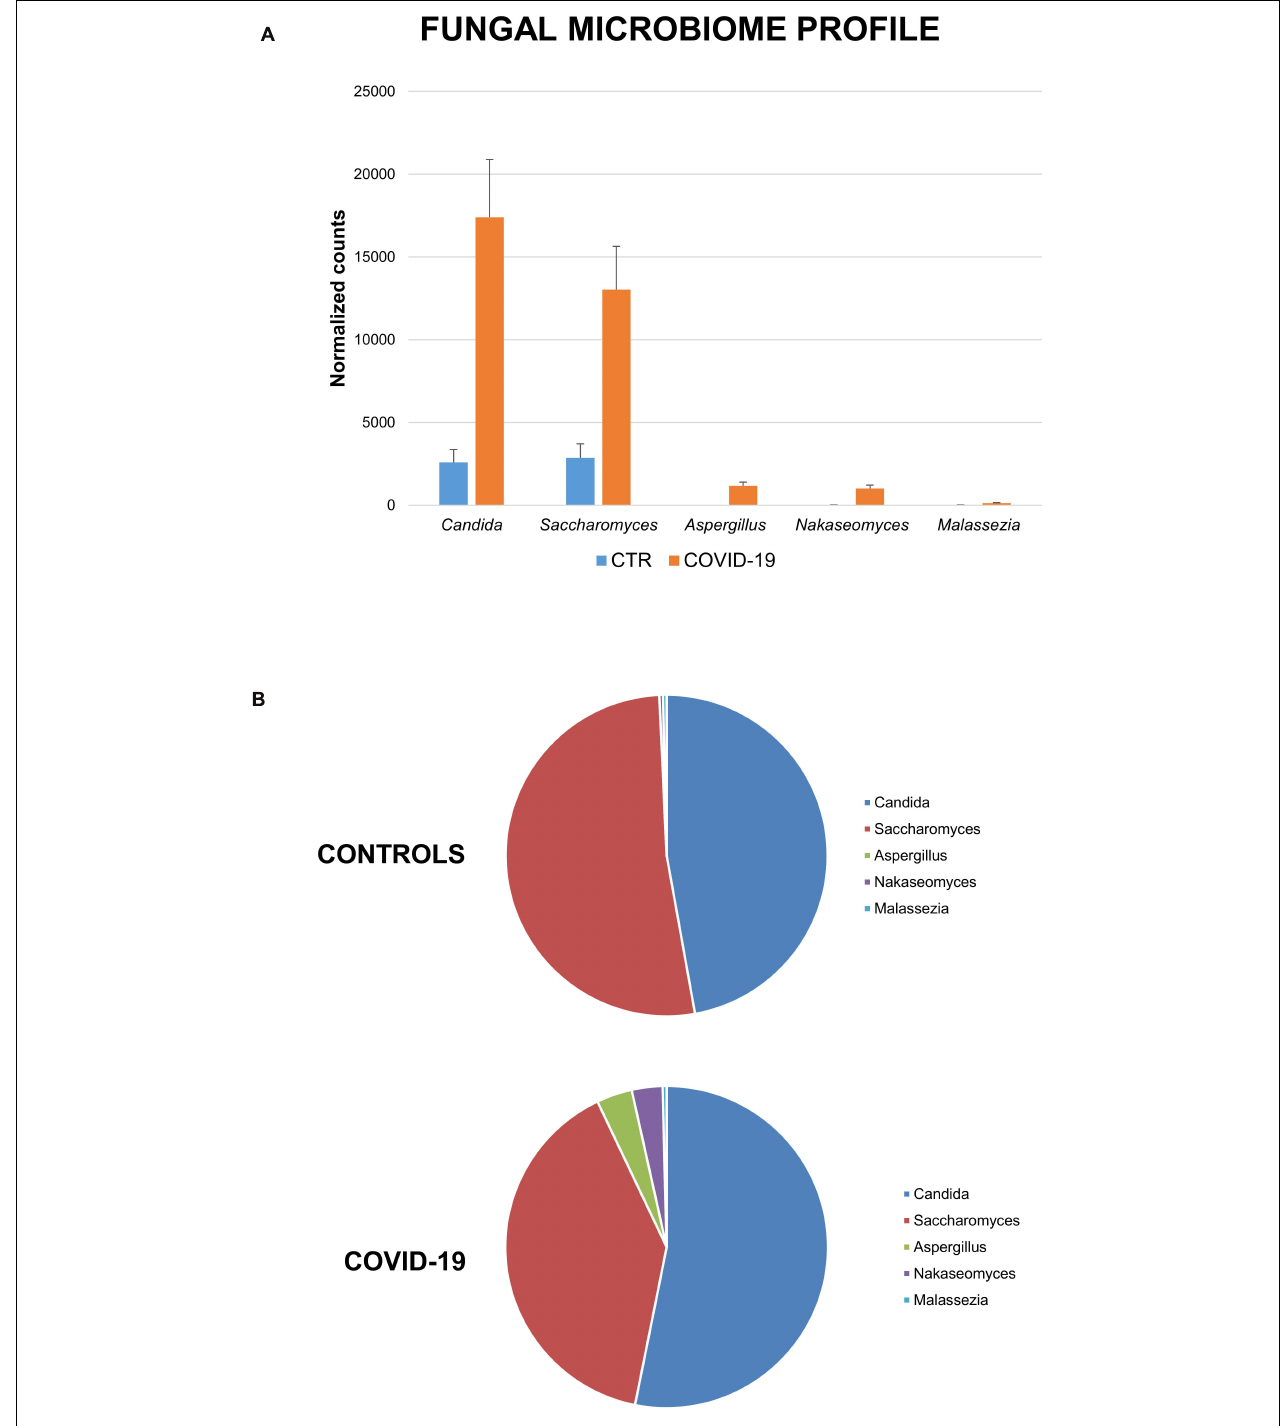
FIGURE 5 | Mycome profile in the oral cavity of control and COVID-19 subjects. (A) Abundance of fungi expressed as total normalized counts for each individually detected mycetes. (B) Percentage distribution of the fungal genera in controls and COVID-19 patients.